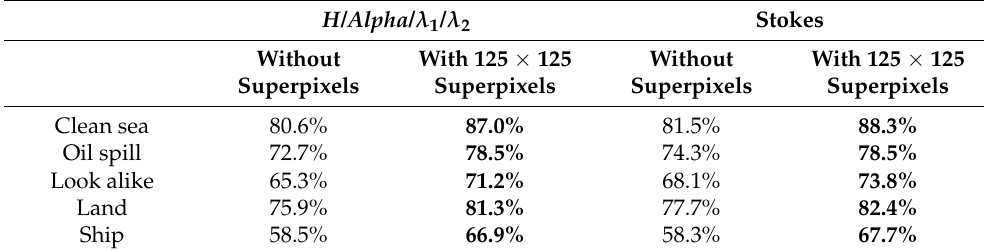
Table 7. IoU values of oil spill detection with and without